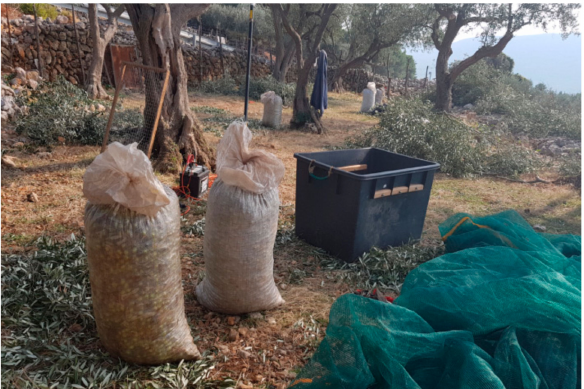
Figure 11. Olive harvesting is still performed mostly the traditional way (Tanja Kremeni´c,